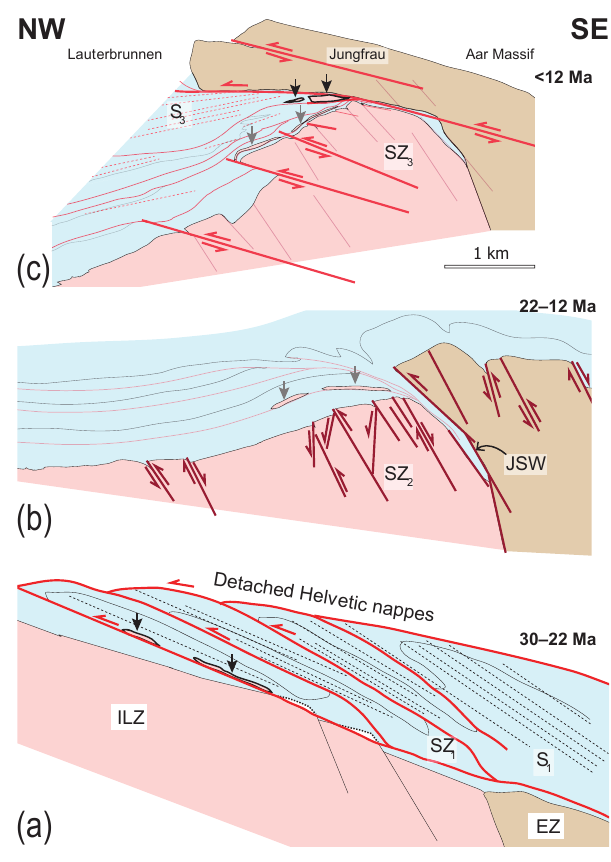
Figure 12. Schematic sketch of the evolution during the main de- formation stages of the Alpine evolution. (a) In-sequence imbricate stacking during the late Kiental phase that induced S1 foliation and led to the incorporation of basement slabs into the sediment stack (black arrows). (b) Steep reverse faulting of SZ2 that induced fold- ing in the cover during the Handegg phase. (c) SZ3 thrusts and S3 foliation in the sedimentary cover during the Pfaffenchopf phase along with a second generation of basement slabs incorporated into the sedimentary cover (black